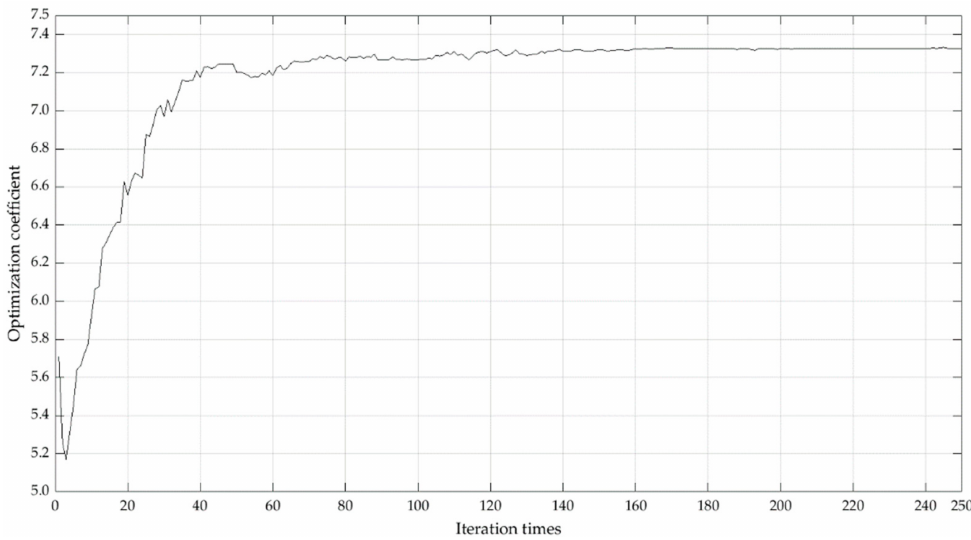
Figure 4. Iteration trend of the optimal projection